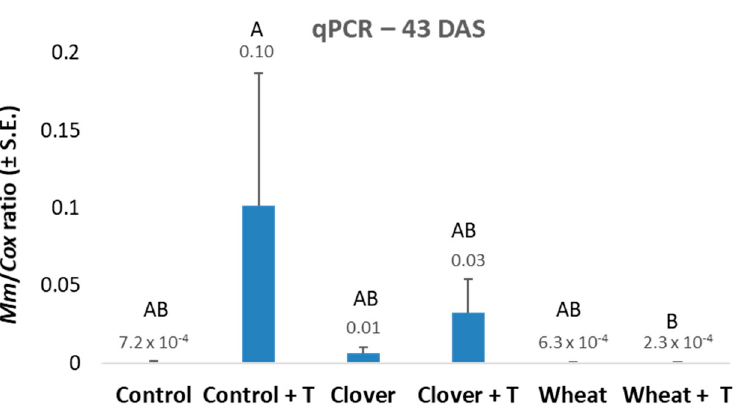
Figure 5. The 2020 commercial fields soil experiment—real-time PCR analysis 43 DAS. The experi- ment is described in Figure 2. The y-axis indicates M. maydis relative DNA abundance in the roots normalized to cytochrome c oxidase ( COX ) DNA. Values indicate an average of 10–12 replications. Error bars indicate standard error. Table 6. The 2020 commercial fields soil experiment—growth parameters at the season end, 71 DAS 1 .